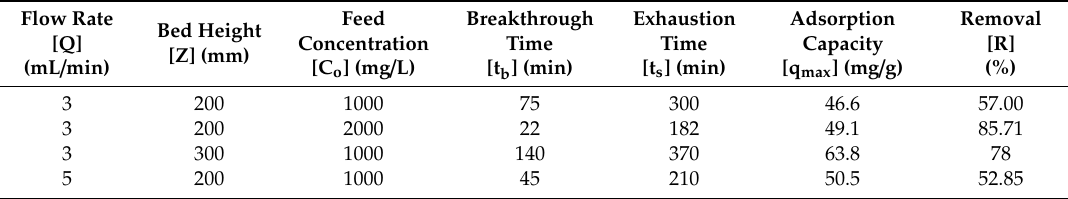
Table 4. Breakthrough curve parameters for sulfate uptake by Ca–CP at variable